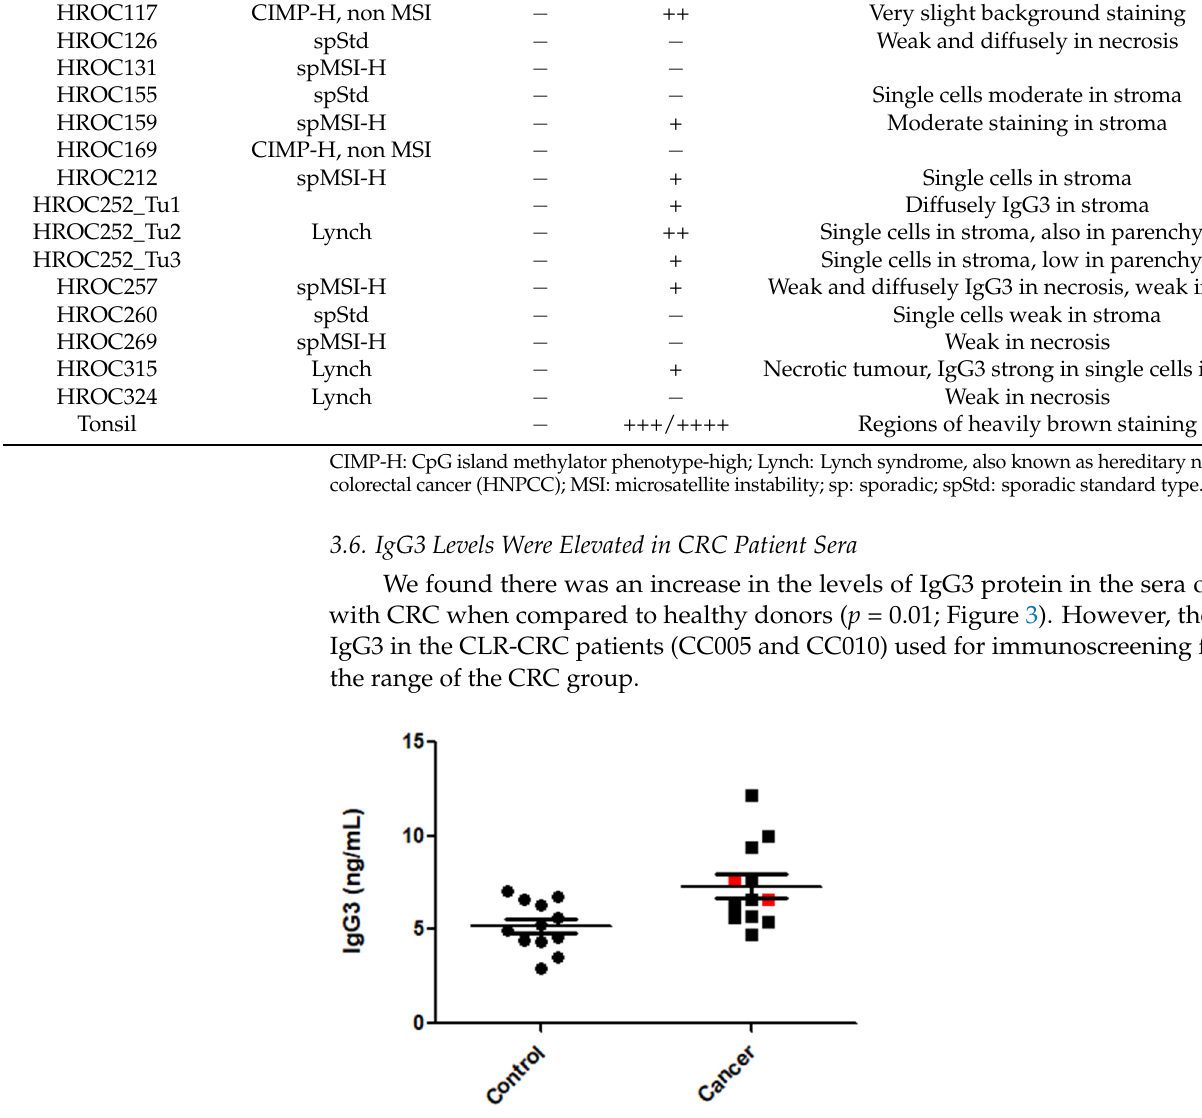
Figure 3. IgG3 levels in CRC patients. Levels of IgG3 were elevated in the sera of CRC patients used for immunoscreening when compared to healthy donors ( p = 0.01), however within this group the IgG3 sera levels in CC005 and CC010 (shown as red squares) were not elevated above the rest of the group of CRC patients.